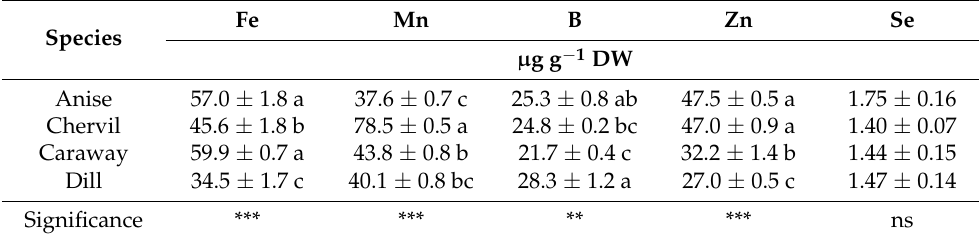
Table 2. Micromineral content of four Apiaceae microgreens species grown in controlled environ- mental